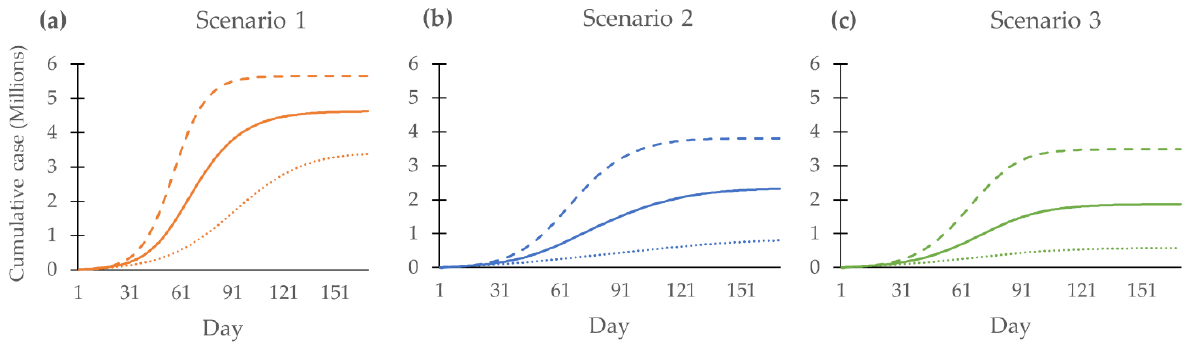
Figure 3. Cumulative cases of all scenarios from day 1 to day 170: ( a ) Scenario 1, no booster dose; ( b ) Scenario 2, viral vector vaccine as booster dose; ( c ) Scenario 3, mRNA vaccine as a booster dose. The solid line shows the mean of the outcome. The dashed line shows the 97.5th percentile of the outcome. The dotted line shows the 2.5th percentile of the outcome.